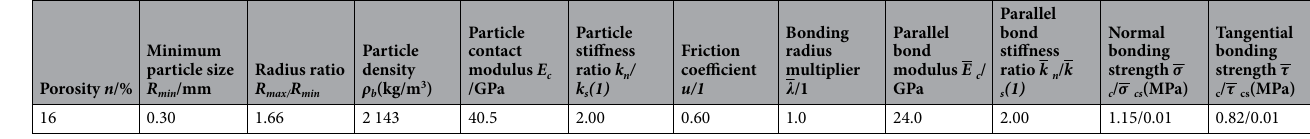
Table 5. PFC Microscopic